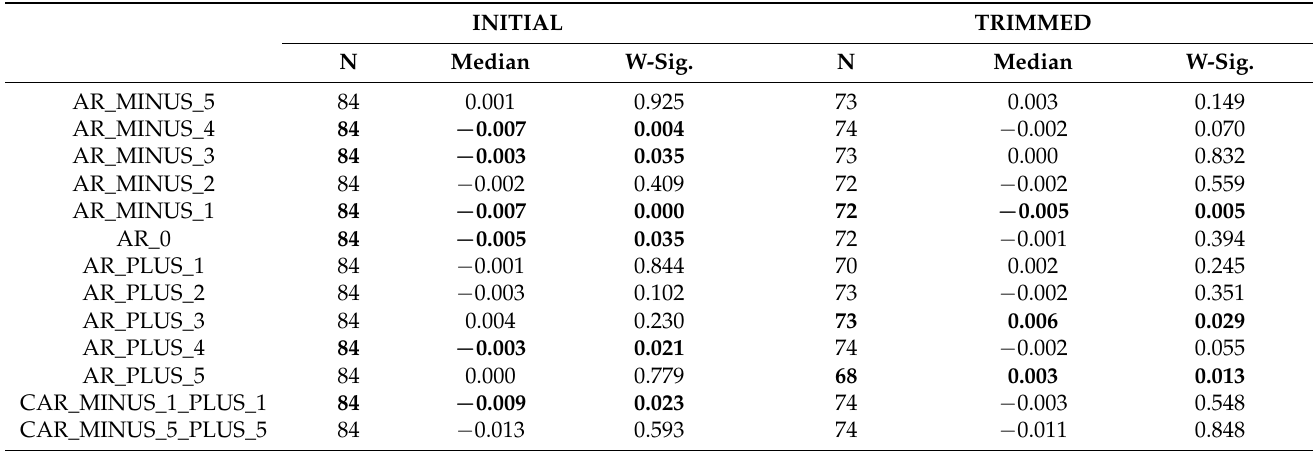
Table 7. Wilcoxon signed-rank test for median daily, average, and cumulative abnormal returns in the initial and trimmed sample (test value = 0).